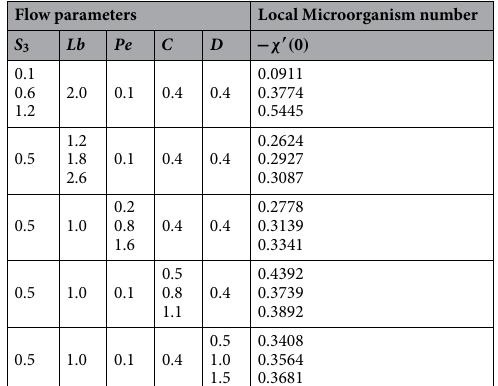
Table 4. Outcomes of